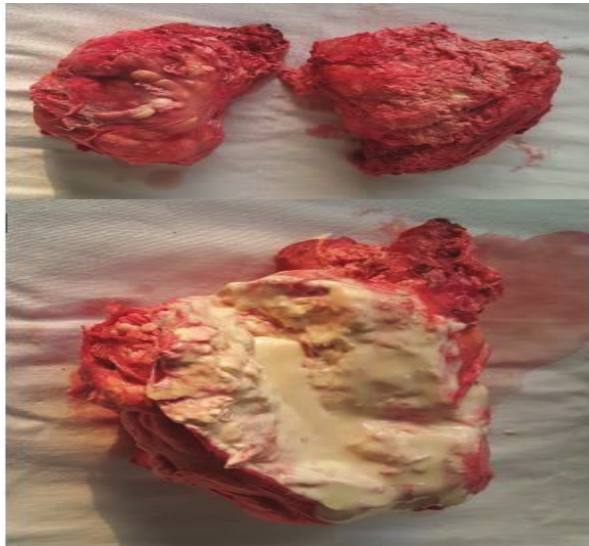
Figure-II: Right hip surgical specimen piece-meal removal, transverse section shows milky white material discharge.